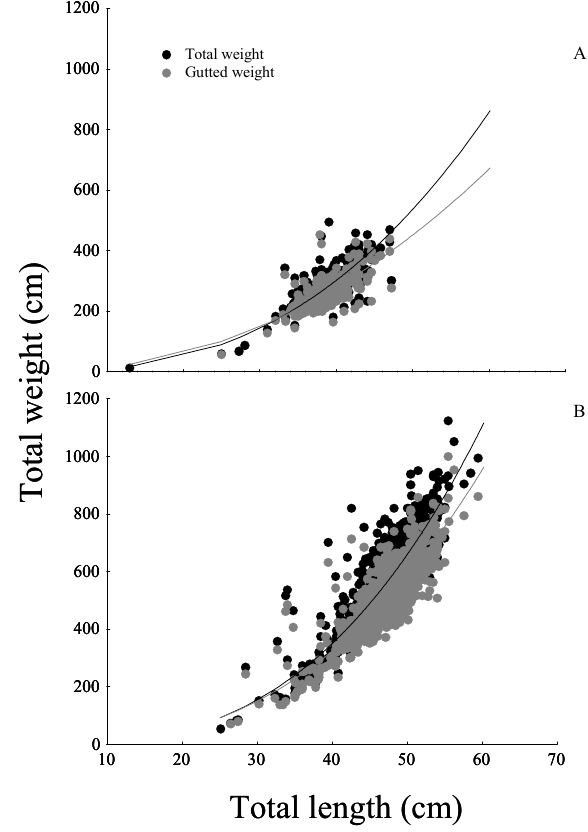
Fig. 5. Relationships between total (black symbols) and gutted weight (g) (grey symbols) for male (above) and females (below) of Rioraja agassizi